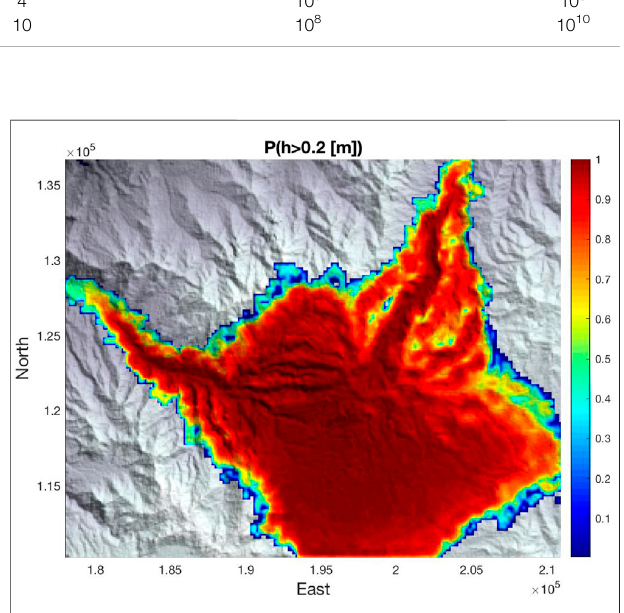
FIGURE 8 | Titan2D emulator based probability of exceeding 0.2 m fl ows in Scenario 1.